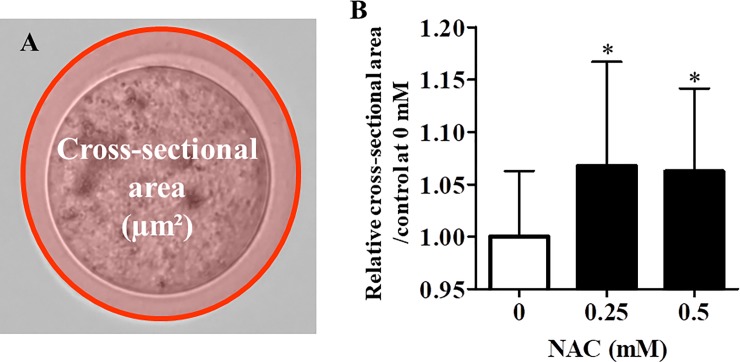
Effect of NAC on zona pellucida expansion in vitrified–warmed oocytes.A) Cross-sectional area of the zona pellucida was measured (31–34 oocytes/experiment). B) The extent of expansion of the zona pellucida was calculated as follows: (cross-sectional area of each group / cross-sectional area in 0 mM NAC) × 100. Results are expressed as mean ± SD (n = 4). *P < 0.05 compared with control (0 mM NAC).